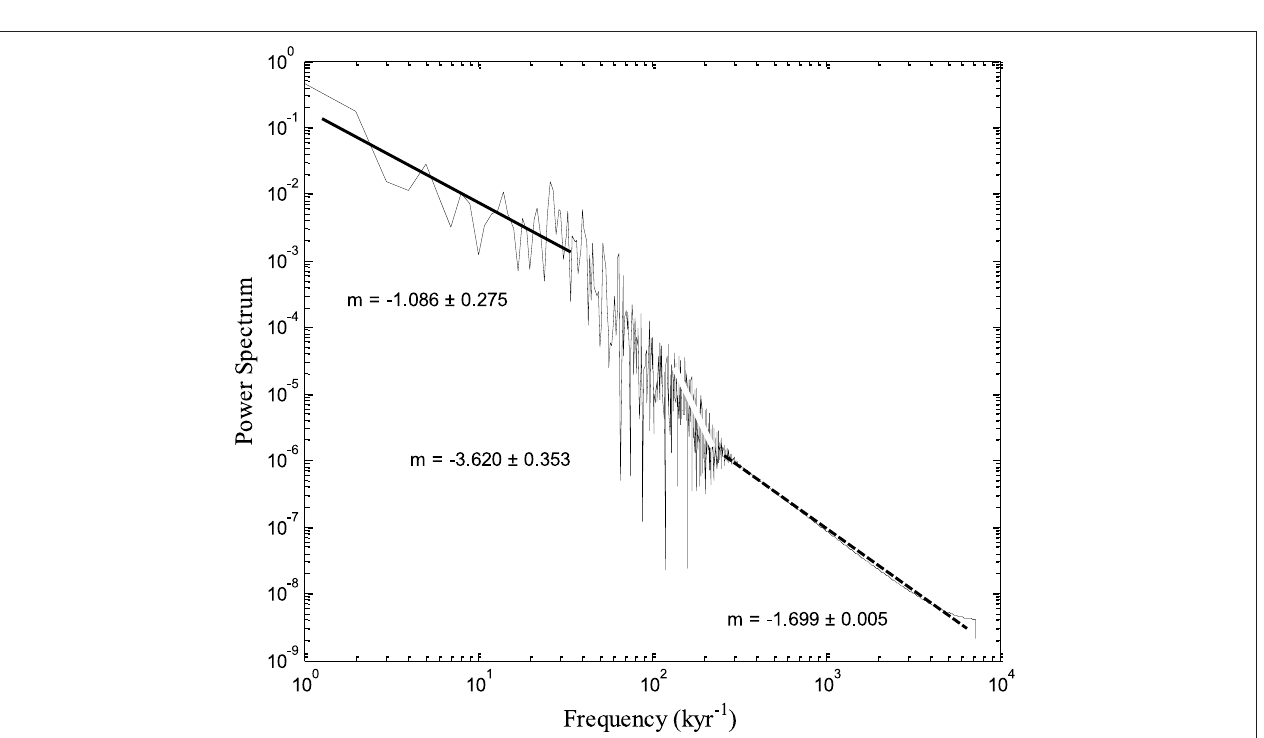
FIGURE 7 | Power spectra (PSD) of the time series generated by the IL model with set of parameter values µ = 0 . 8 , m = 1 . 8 , l = 1 . 9 , r = 2 . 0 , c = 1 . 0 , g = 0 . 25 , N = 15 .